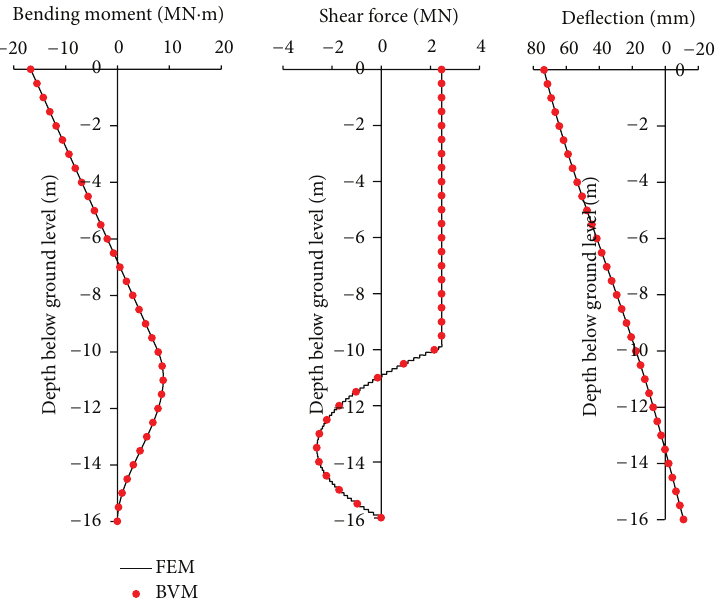
Figure 6: Comparison of internal force and deflection of front row pile between the boundary value method and FEM.